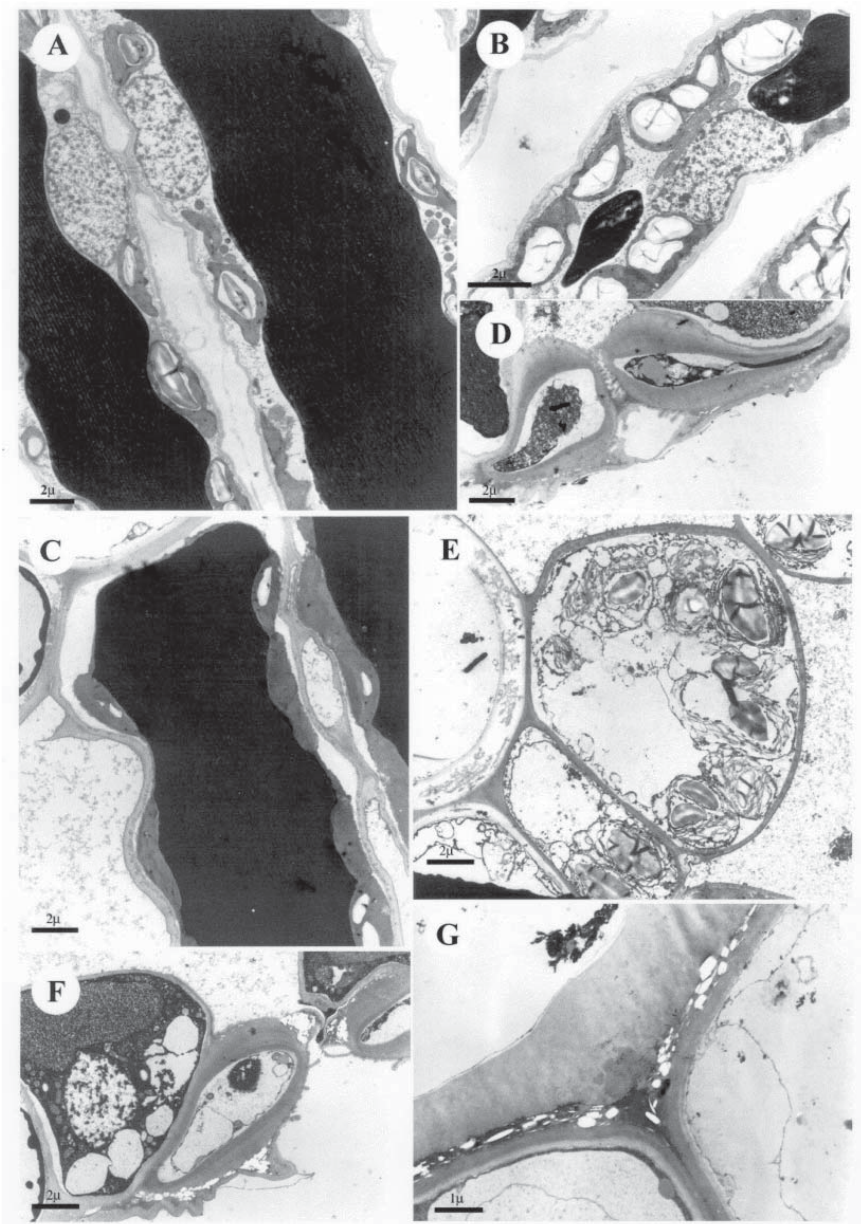
Fig. 3. Transmission electron microscopy (TEM) sections of Platanus acerifolia leaves. (A) Palisade cells of a control leaf: particular showing chloroplasts containing starch grains. Bar=2µm. (B) Cerato-platanin (CP) treated leaf: palisade cell(s) presenting chloroplasts with large starch reserves. Bar=2µm. (C) Some spongy cells of CP treated leaf: note the low starch content, detachment of cytoplasm from the walls and plasmolysis phenomena. Moreover, the chloroplast structure is not clearly distinguishable. Bar=2µm. (D) Guard cells of control leaf exhibiting normal structure. Bar=2µm. (E) Spongy cells of the leaf under the CP-treated zone: the chloroplasts show a disorganized tylacoidal system as well as starch grains, and the cytoplasm has a degenerated appearance with fragmented membranes and vesicular parts, no nuclei are visible, and plasmolysis processes are evident. Bar=2µm. (F) A particular of a stoma in a CP-treated leaf showing crystal- line material, cytoplasm and nucleus alterations in the outer cell walls. Bar=2µm. (G) Particular of a CP-treated leaf epidermis: abundant crystalline material occurs in the middle part of the cell walls.